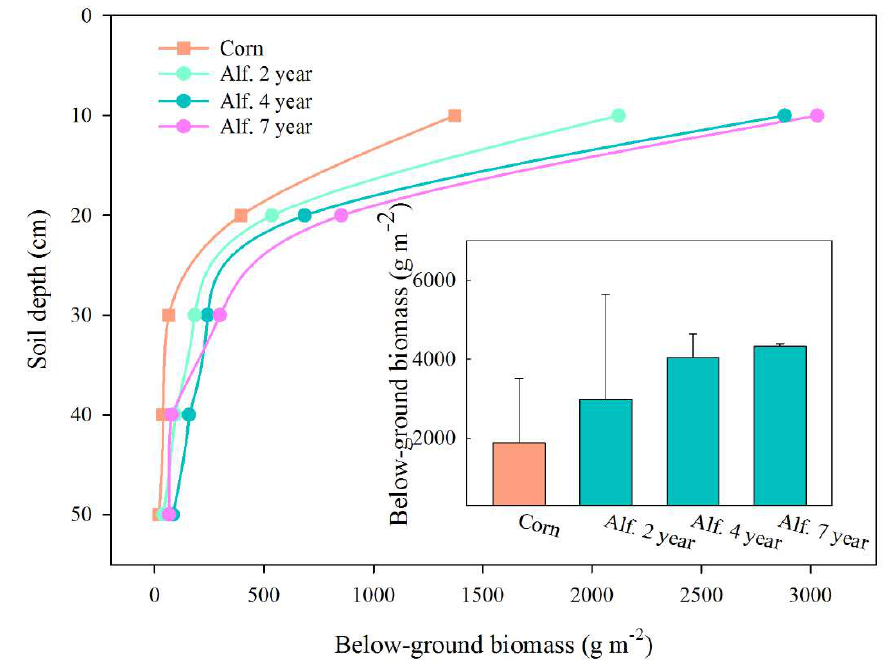
Figure 6. Vertical distribution of the below-ground biomass of the cornfield and the two-, four- and seven-year-old alfalfa pastures. The column chart on the right side shows the total below-ground biomass at 0–50 cm soil depth.